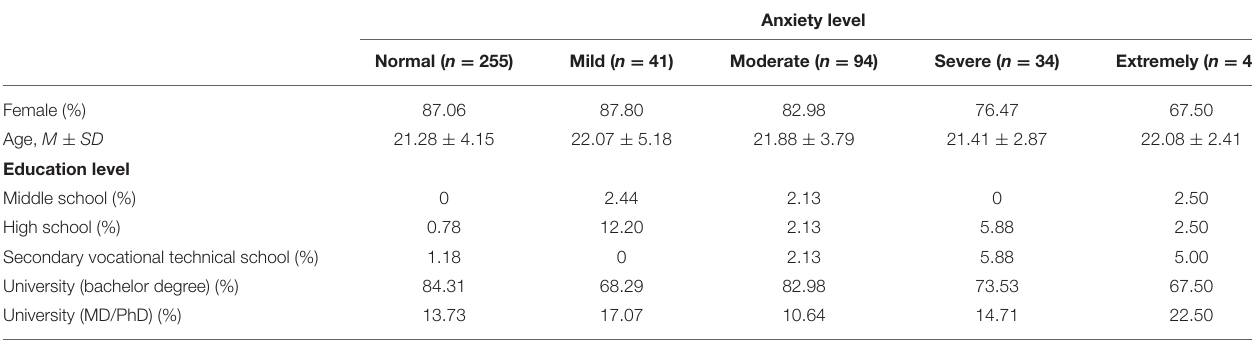
TABLE 1 | The distribution of anxiety levels in this sample.